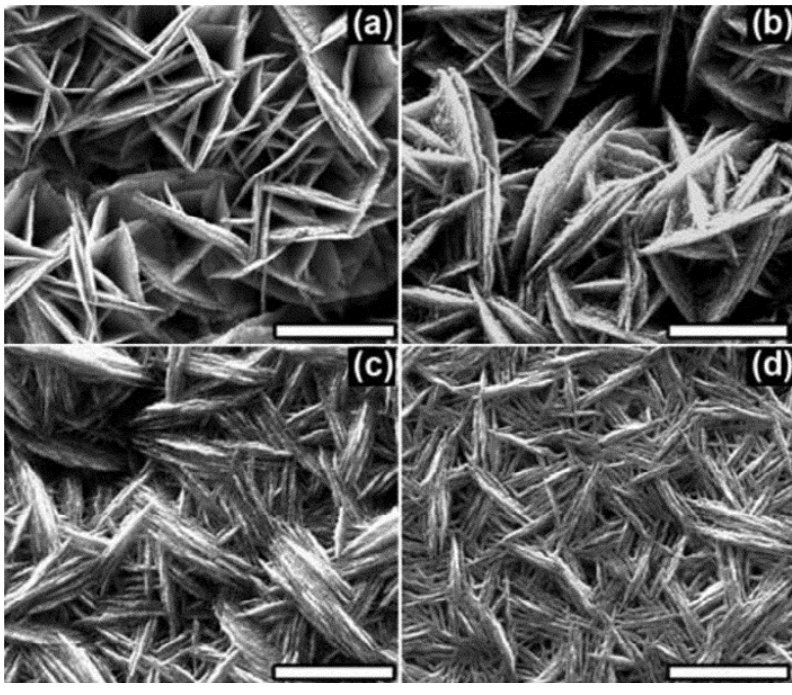
Fig. 8: SEM images of silver nanostructures produced by immersing the P–CNTs membranes doped by citric acid in (a) 15, (b) 25, (c) 50 and (d) 100 mM AgNO solution for 30 min, scale bar: 1 µm. 3 Reproduced with permission from ref.38, copyright 2010, Royal society of